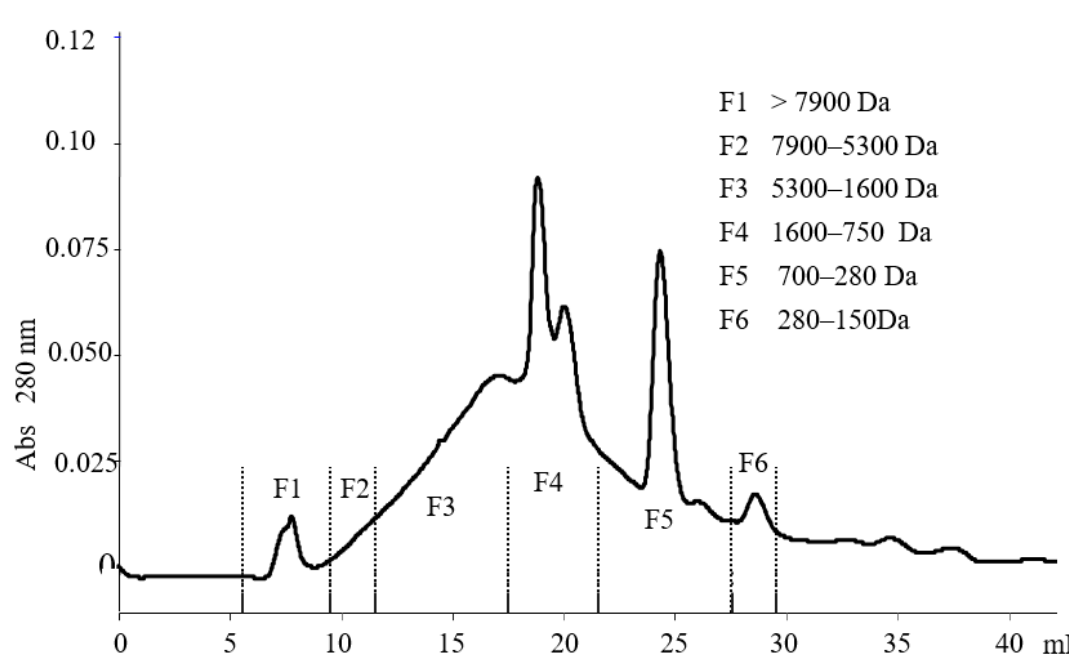
Figure 1. Separation of peptides extracted from unfiltered virgin olive oil by gel filtration chromatography and FPLC.